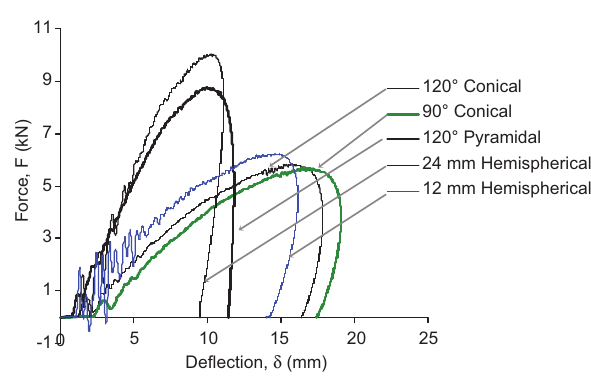
Figure 8 The variation of the force vs. defl ection for various impactors.